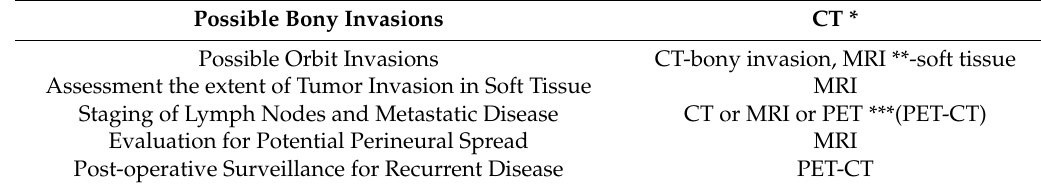
Table 6. Indications for Radiologic Imaging for Skin Cancers and Recommended Imaging Studies [107,108]. Possible Bony Invasions CT * Possible Orbit Invasions CT-bony invasion, MRI **-soft tissue Assessment the extent of Tumor Invasion in Soft Tissue MRI Staging of Lymph Nodes and Metastatic